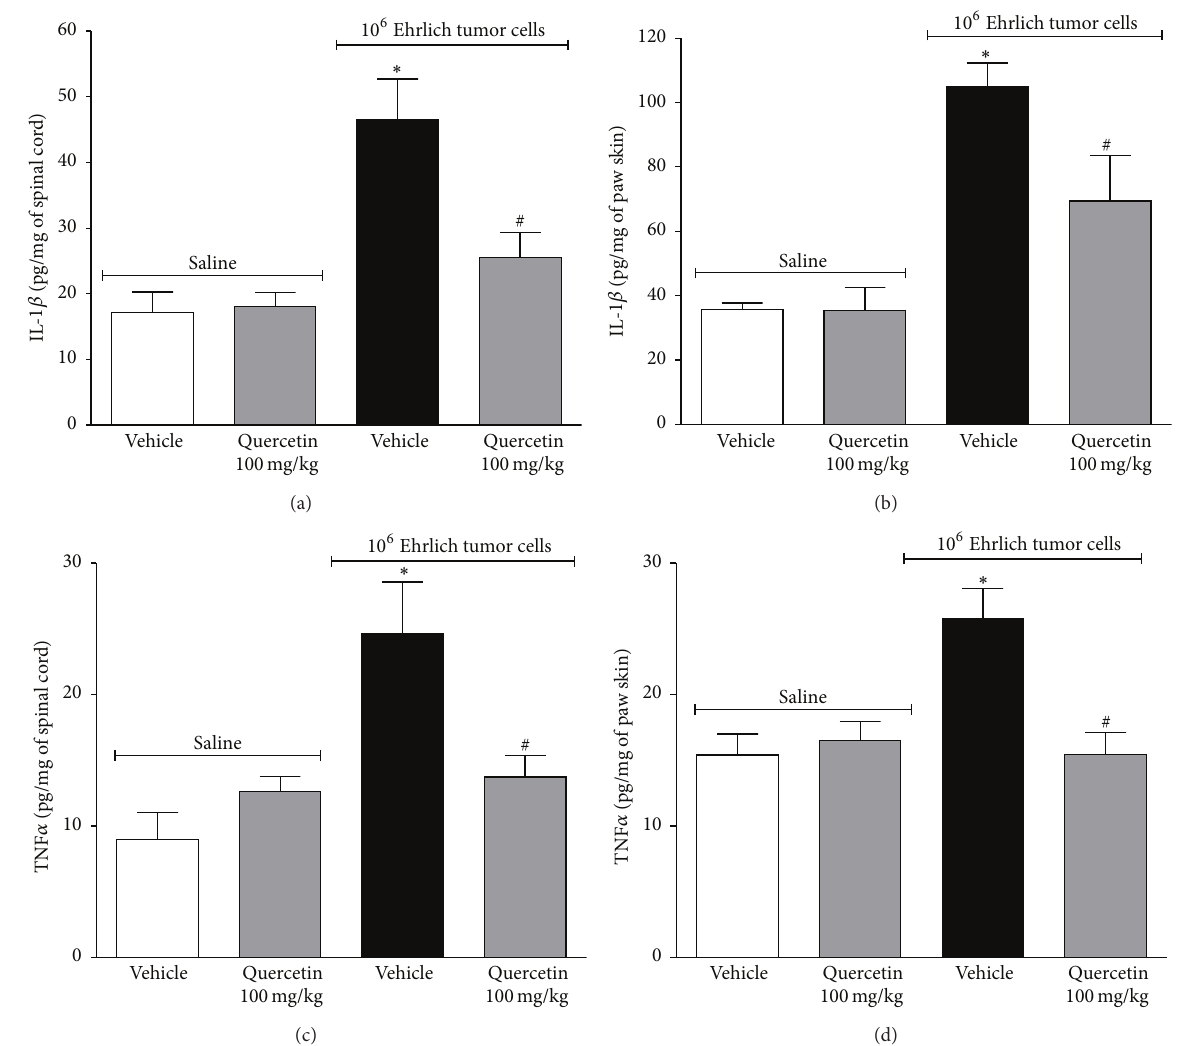
Figure 5: Quercetin inhibits IL-1 𝛽 and TNF 𝛼 production induced by Ehrlich tumor cells in the spinal cord and paw skin. Mice were treated i.p. with quercetin (100mg/kg, 2% DMSO diluted in saline) or vehicle (2% DMSO) 10min after the injection of Ehrlich tumor cell (1 × 10 6 /25 𝜇 L) or saline (25 𝜇 L). The treatment continued daily. In the 12th day after injection, the Ehrlich tumor cells, the spinal cord, and the paw skin samples were collected for cytokine measurement. IL-1 𝛽 in spinal cord (a) or paw skin (b) and TNF 𝛼 in spinal cord (c) or paw skin (d) were determined by ELISA. Data are presented as means ± SEM of six mice per group per experiment and representative of two separated experiments: ∗ 𝑝 < 0.05 compared to the saline group and # 𝑝 < 0.05 compared to the tumor group. One-way ANOVA followed by Tukey’s